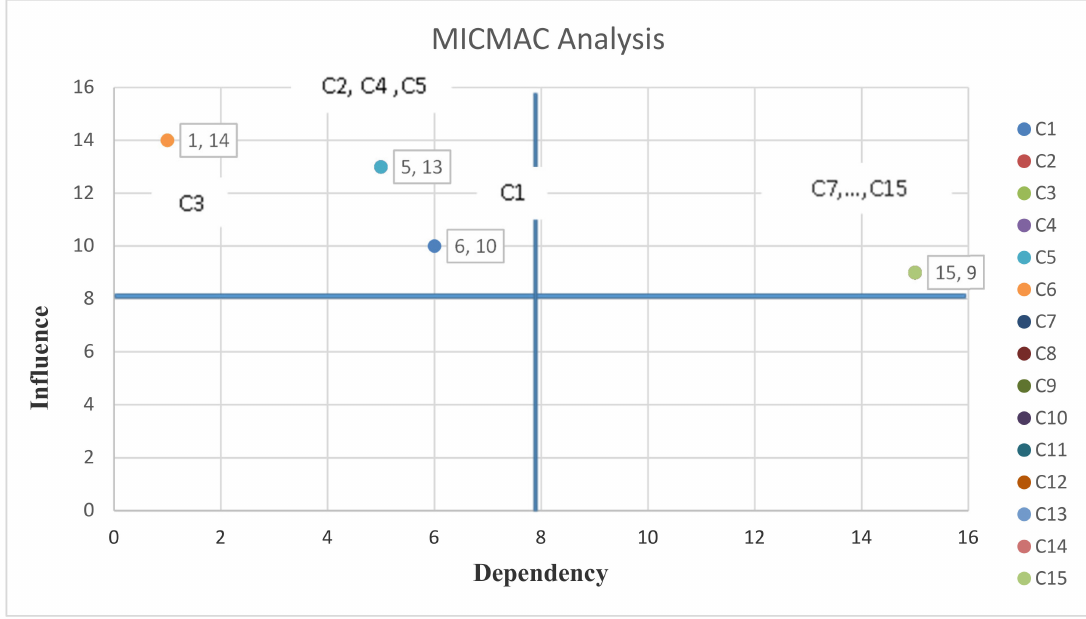
Figure 7. Interpretive structural modeling and MICMAC